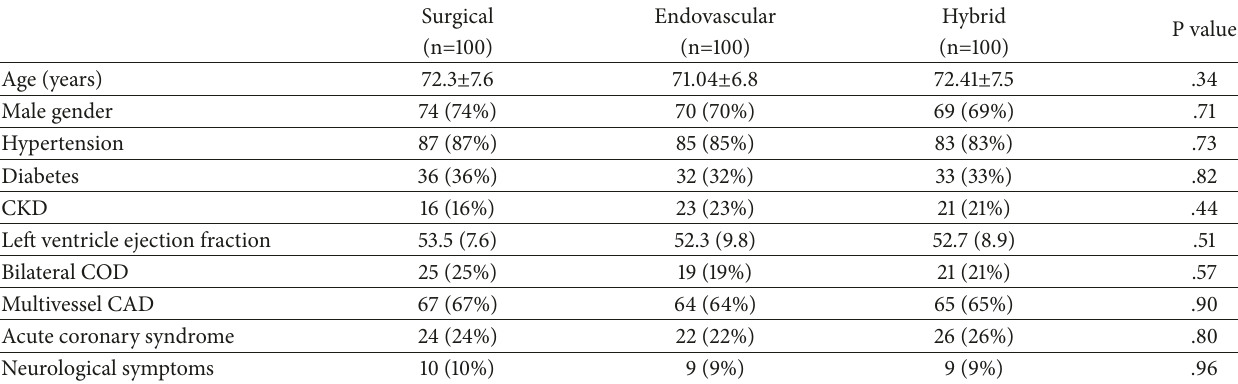
Table 5: Baseline characteristics and their distribution among the three groups in the propensity-matched